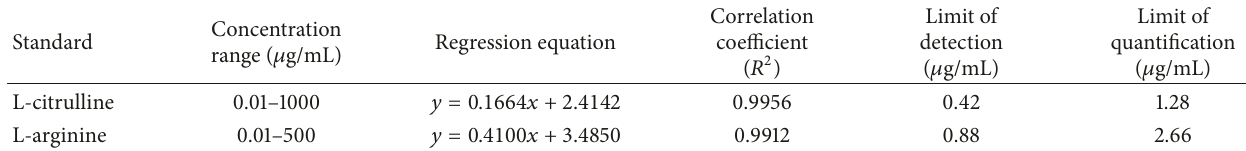
Table 2: Calibration data of L-citrulline and L-arginine standard reported from isocratic RP-HPLC method. Standard